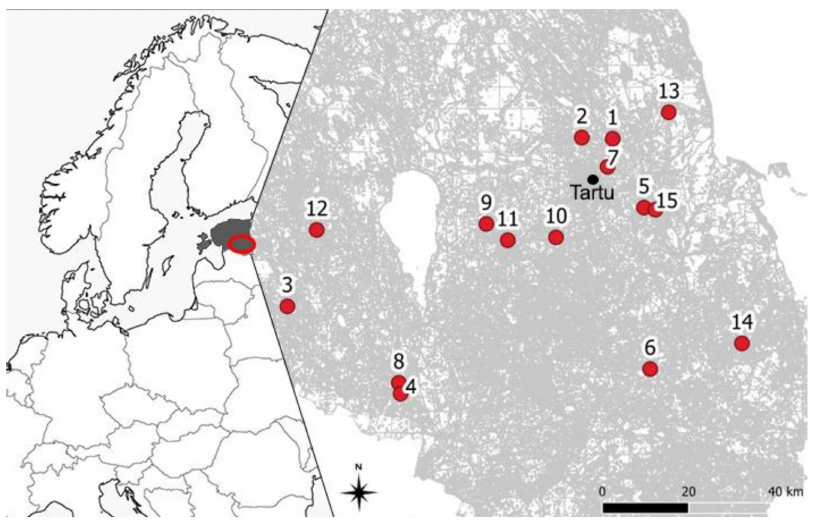
Figure 1. A schematic overview of the location of the study area on the European map ( left ) with detailed southern Estonian region ( right ) zoomed out. The 15 study locations around Tartu city are indicated with red circles and